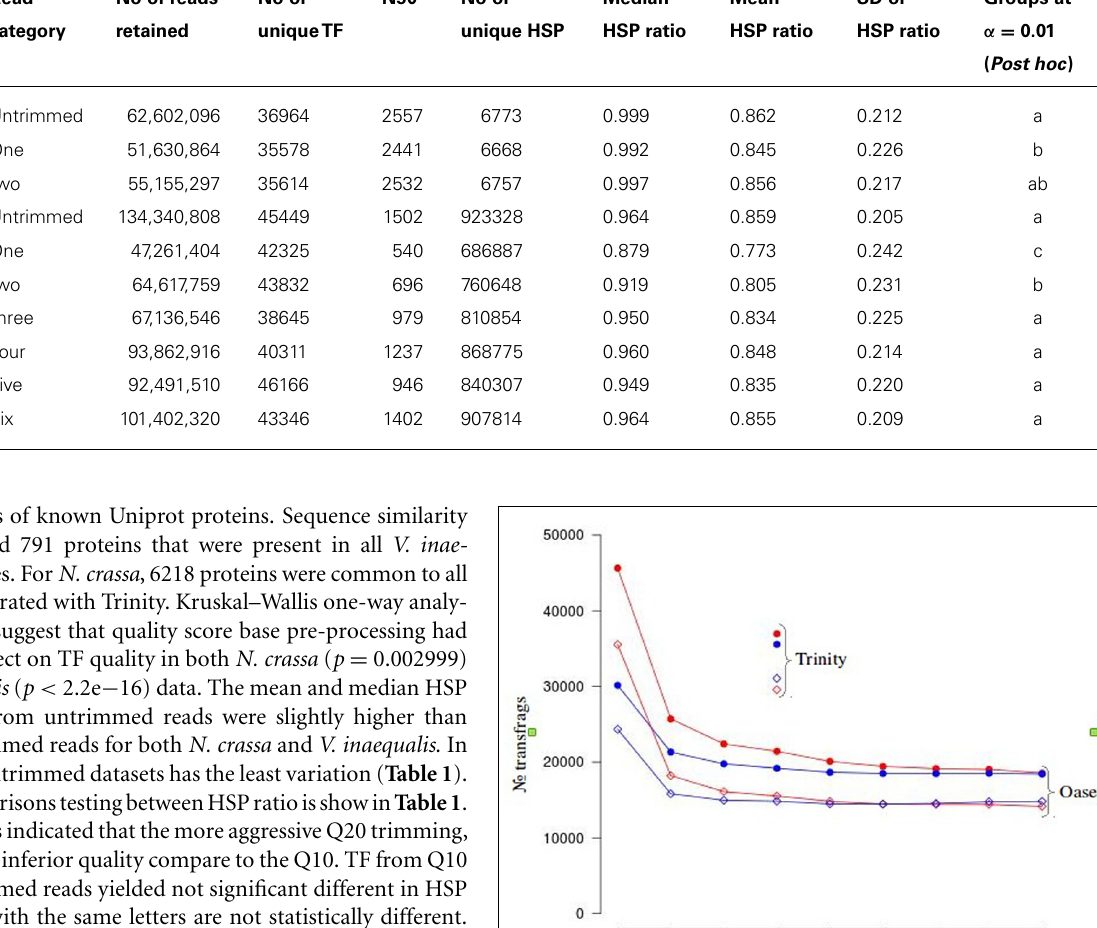
Table 1 |Attributes of transfrags produced withTrinity. Organism